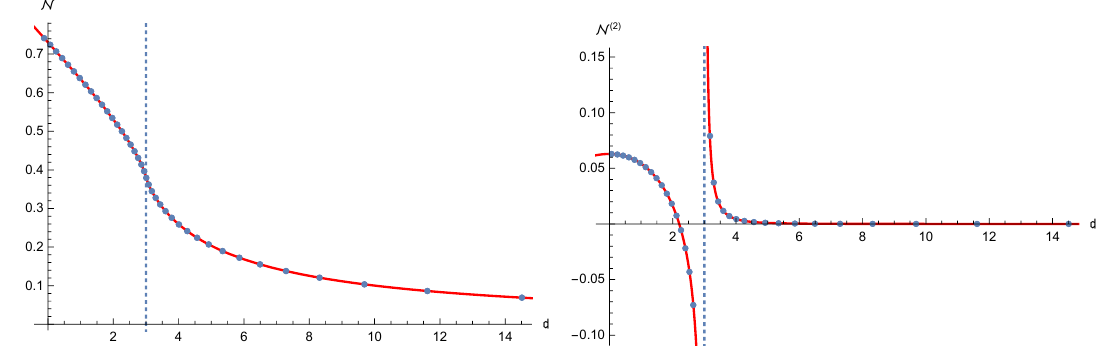
Figure 12 . (Left panel) Comparison of the numerical data for the states with (cid:1)(0) = 3 + 4 n at (cid:24) = 29 against the WKB expansion (8.56) (with hypergeometric series replaced by their real part for d < 3). (Right panel) Comparison of O (1 =(cid:24) 2 ) correction to the WKB expansion (8.56) with the numerical data. Blue dots denote the numerical data with the leading order correction (8.52) subtracted, red line describes O (1 =(cid:24) 2 ) correction to